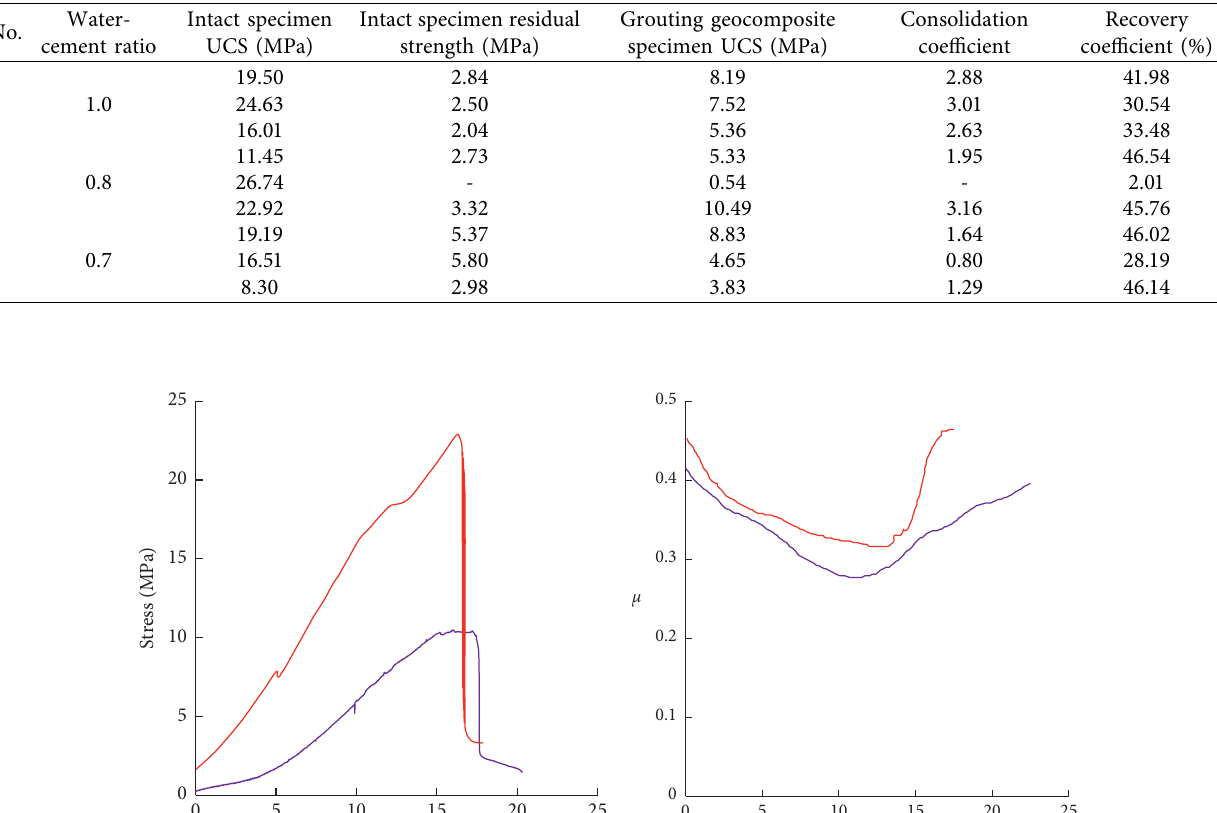
Figure 6: Grouting geocomposite specimen (a) and its broken pieces (b). Table 1: Mechanical properties of coal specimen before and after grouting.